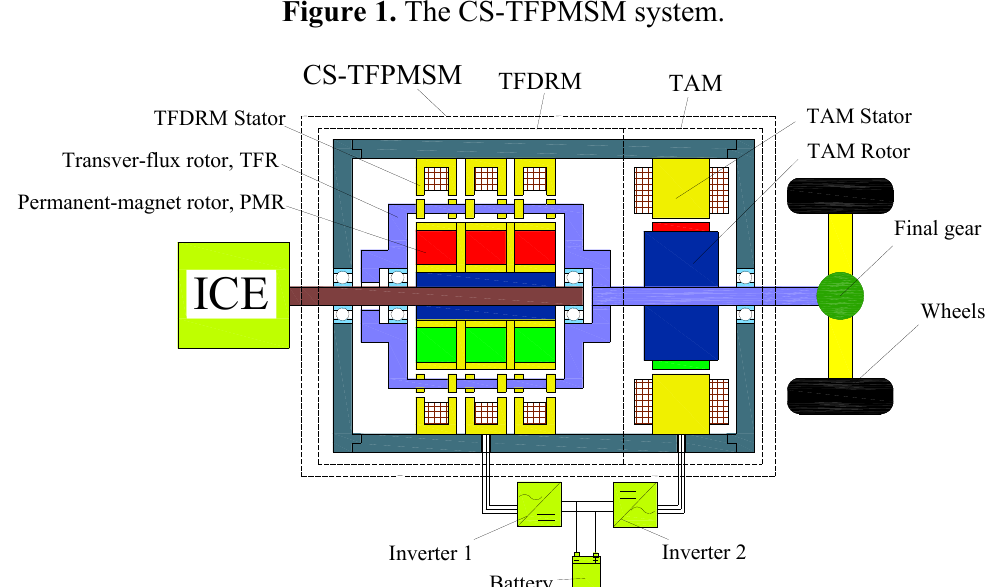
Figure 1. The CS-TFPMSM system.